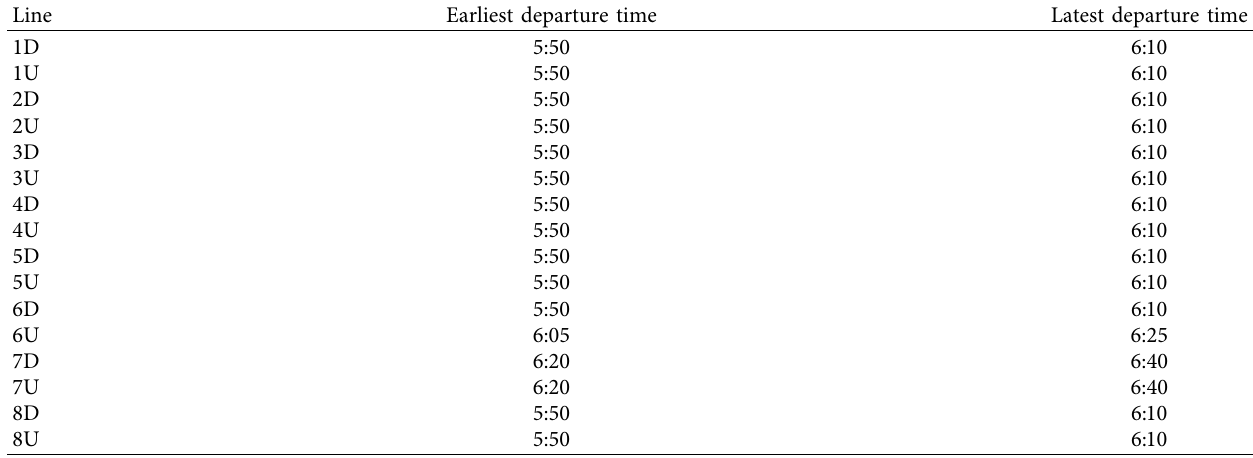
Table 4: The earliest and latest departure times of the first trains.